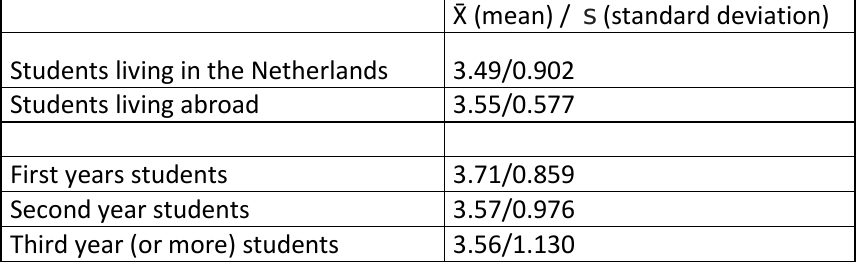
Table 2 "I have sense of belonging within the Honours community"; N=40 .